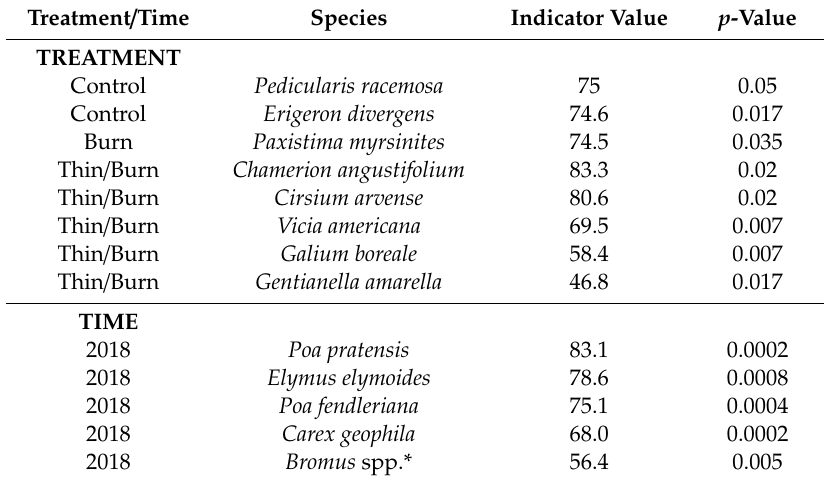
Table 1. Herbaceous / prostrate shrub indicator species associated with restoration treatments in 2018, 10 years post-treatment, and graminoid indicator species associated with time. We accepted species with indicator values (relative abundance x relative frequency) > 45 and p values ≤ 0.05 as indicator species for a specific treatment (control, burn, thin / burn) or time (2003-pretreatment, 2009-1 year post-treatment, and 2018-10 years post-treatment). There were no 2003 or 2009 indicator graminoid species. Bromus spp.* includes B. ciliatus , B. lanatipes , and < 5% B. inermis .